Question: What type of chart is this?
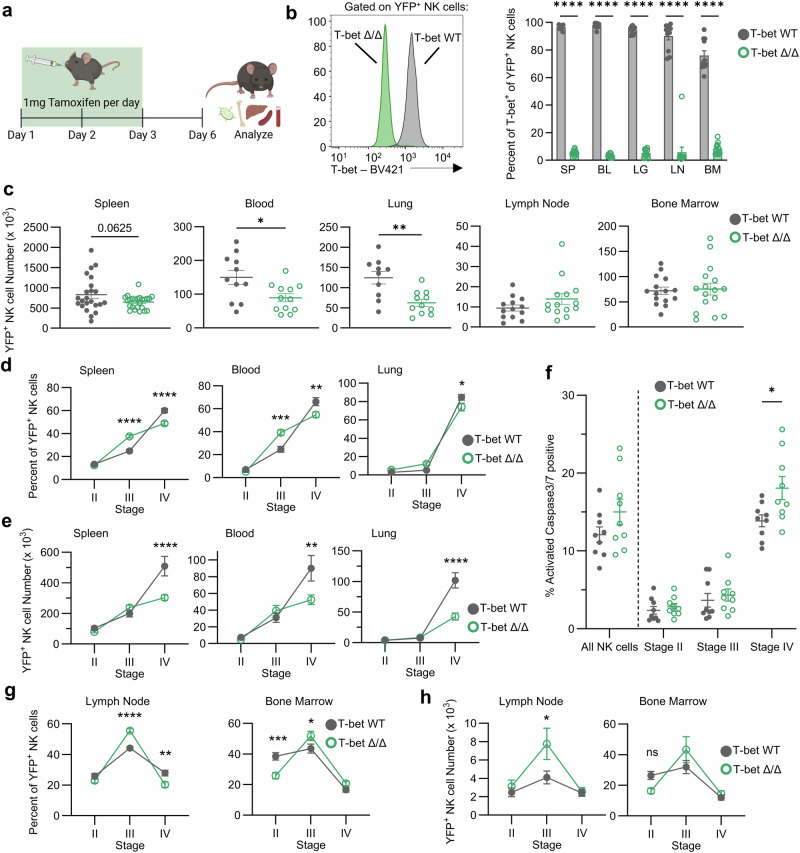
Answer: histogram